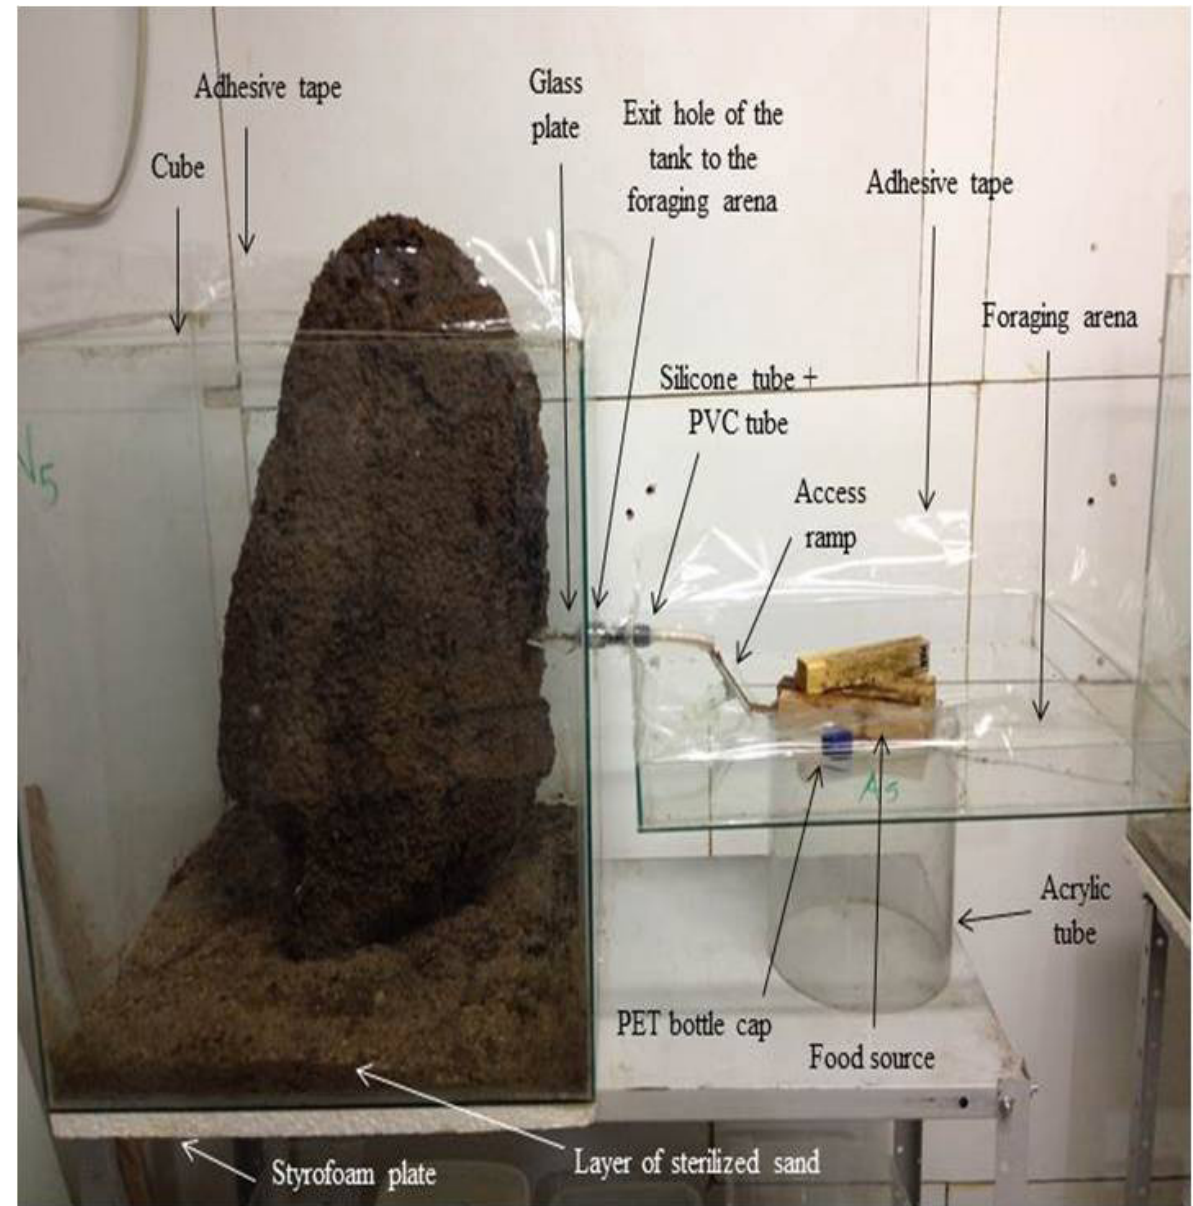
Fig 1 . Cube, for the colonies of Nasutitermes corniger , connected to the foraging